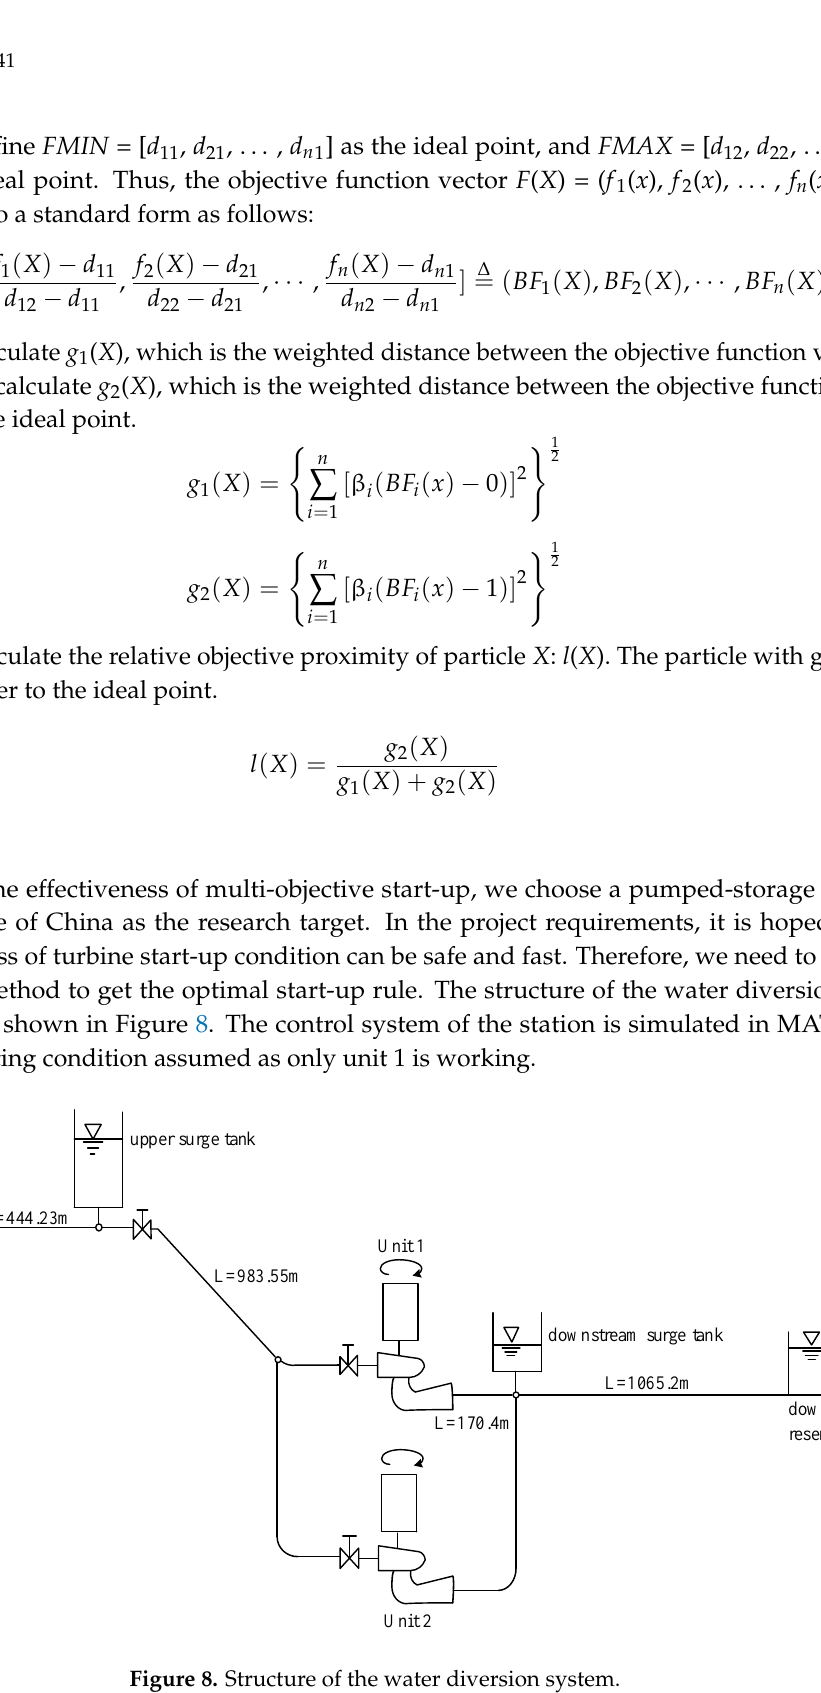
Figure 8. Structure of the water diversion system.